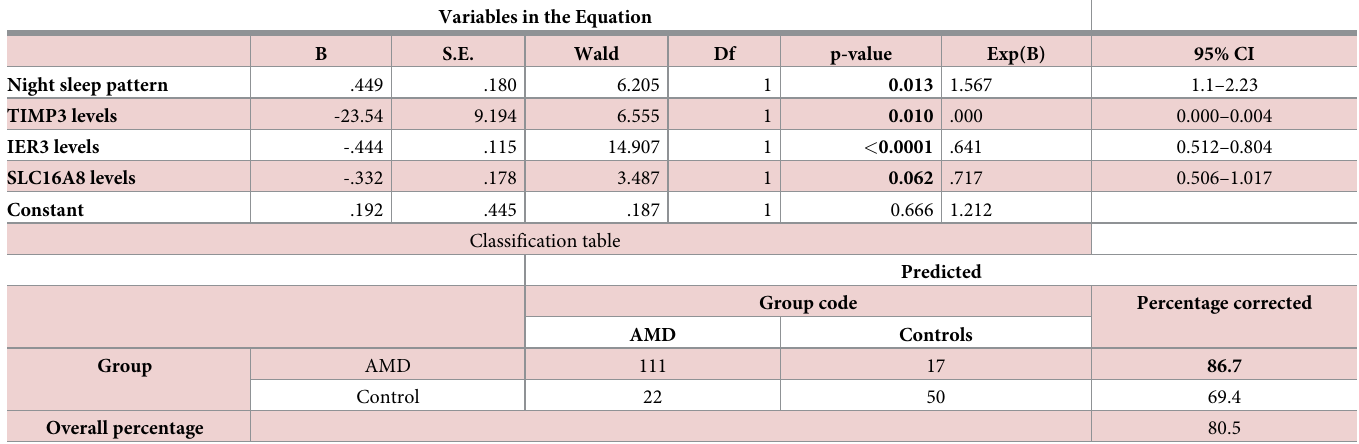
Table 7. Regression analysis to predict the AMD pathology under the influence of